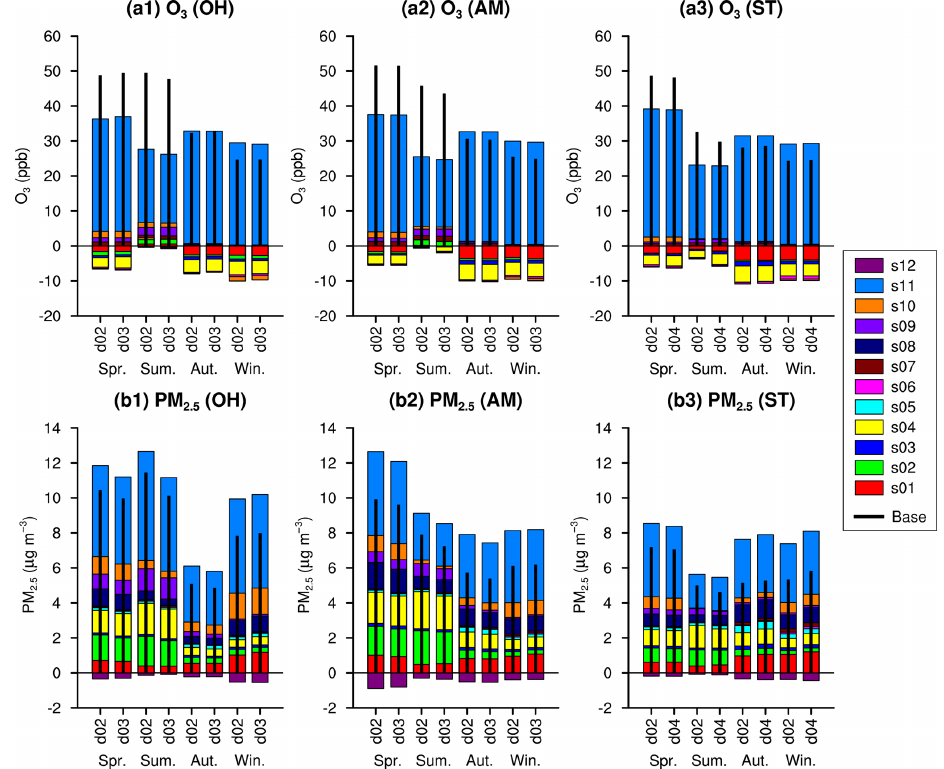
Figure 5. Sensitivities of the simulated ozone and PM 2 . 5 concentrations to all source groups over OH, AM, and ST evaluated in d02, d03, and d04 for the 2 target weeks in the four